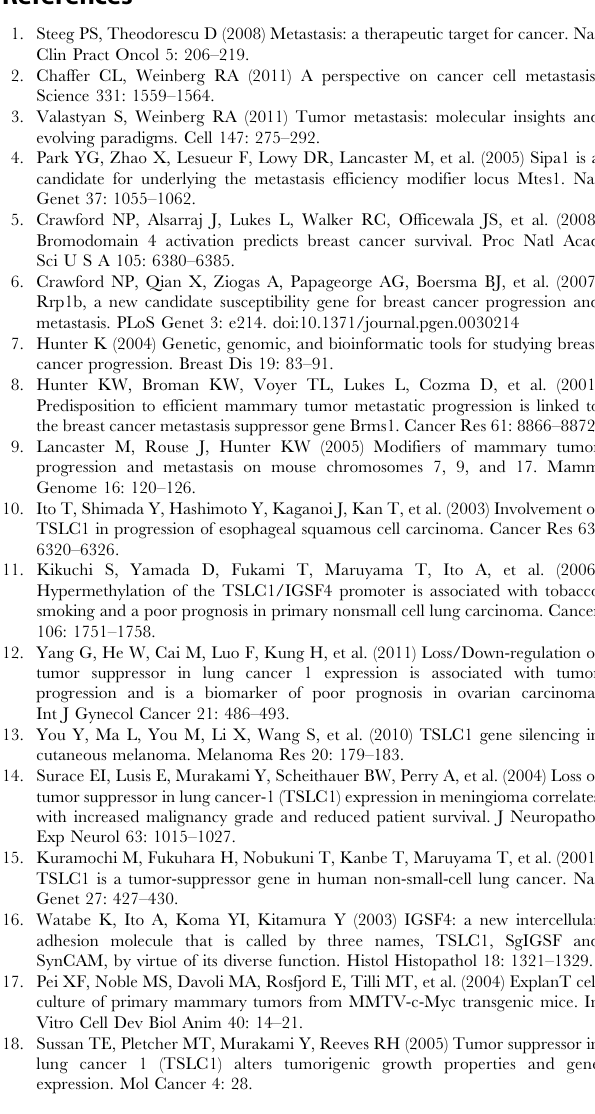
Figure S8 Flow cytometry demonstrating CD8 + T cell depletion in the peripheral blood of one representative sample from each group (a, b, c, d). Figure S9 Protein-level Cadm1 expression in Mvt-1 cell lines directly prior to injection into animals for in vivo studies in immune-competent (FVB), athymic (nude), and antibody treated mice. Table S1 Breast cancer patient dataset details. n, number of patients per group; LN, lymph node; ER, estrogen receptor; IDC, invasive ductal carcinoma; TCGA, The Cancer Genome